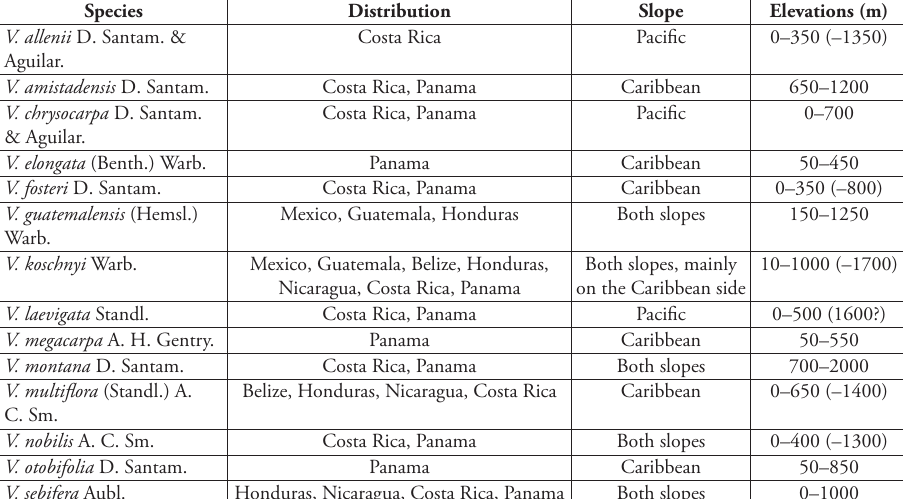
Table 1. List of the 14 accepted species of Virola in Mesoamerica with countries of occurrence, slope preference and elevation within